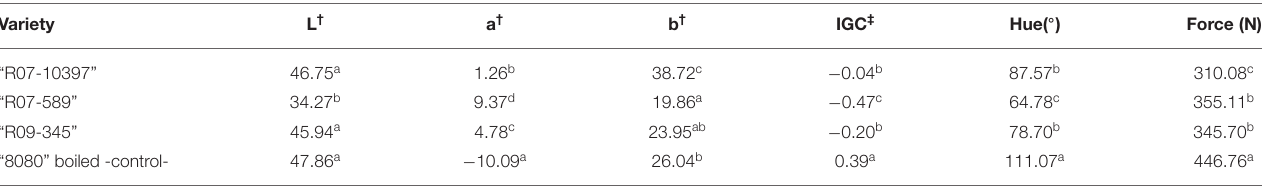
TABLE 3 | Color values and texture of three edamame varieties harvested at the R6 stage and acid-processed after pasteurization, and an unprocessed sample of a commercial variety blanched used as check. Variety